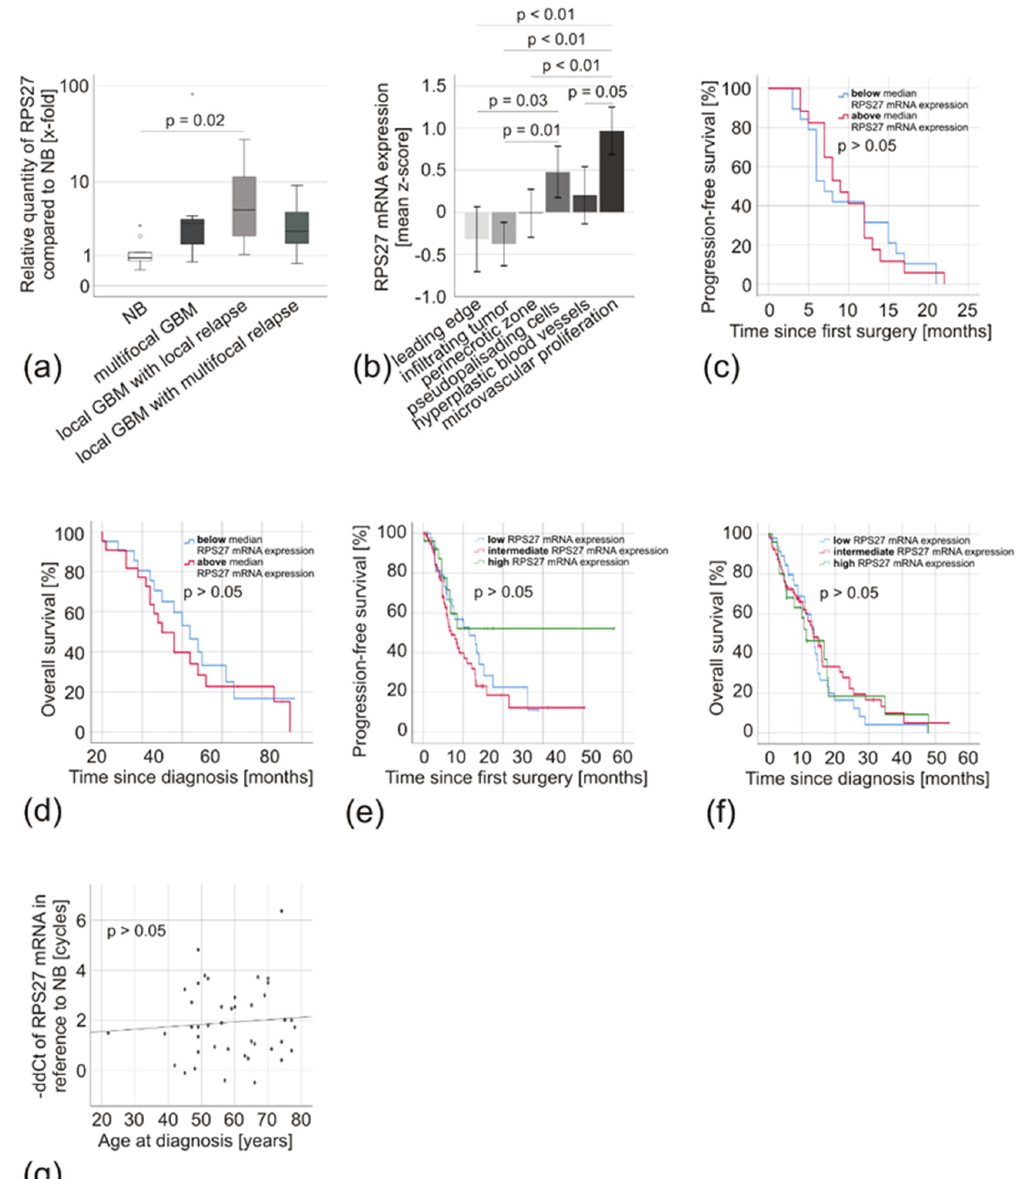
Figure 7. RPS27 mRNA expression in GBM specimens. ( a ) Box-plot of RPS27 mRNA expression of primary GBM with different growth patterns (multifocal GBM n = 7, local GBM with local relapse n = 24, local GBM with multifocal relapse n = 12) compared to NB ( n = 8). The median is displayed by the middle line, the quartiles are represented by the hinges, extreme values up to 1.5 times the height of the box are shown by whiskers and outliners represented by points. ( b ) IVY-GAP database [32] analysis of RPS27 mRNA expression in different areas of GBM: leading edge ( n = 19), infiltrating tumor ( n = 24), perinecrotic zone ( n = 26), pseudopalisading cells around necrosis ( n = 40), hyperplastic blood vessels in cellular tumor ( n = 22), and microvascular proliferation ( n = 28). ( c ) Kaplan–Meier analysis comparing the progression-free and ( d ) the overall survival of GBM patients with RPS27 mRNA expression below (blue, n = 22 and n = 21, respectively) and above (red, n = 17 and n = 22, respectively) the median expression of 2.7 fold by Breslow test. ( e ) Kaplan–Meier analysis comparing the progression-free and ( f ) the overall survival of GBM patients with low (blue, n = 47), intermediate (red, n = 78) and high (green, n = 26) RPS27 mRNA expression. TCGA data were exported from the CBioportal analysis tool [33]. ( g ) Scatter diagram of RPS27 mRNA expression compared with the age of GBM patients. Linear regression, p -value based on ANOVA.